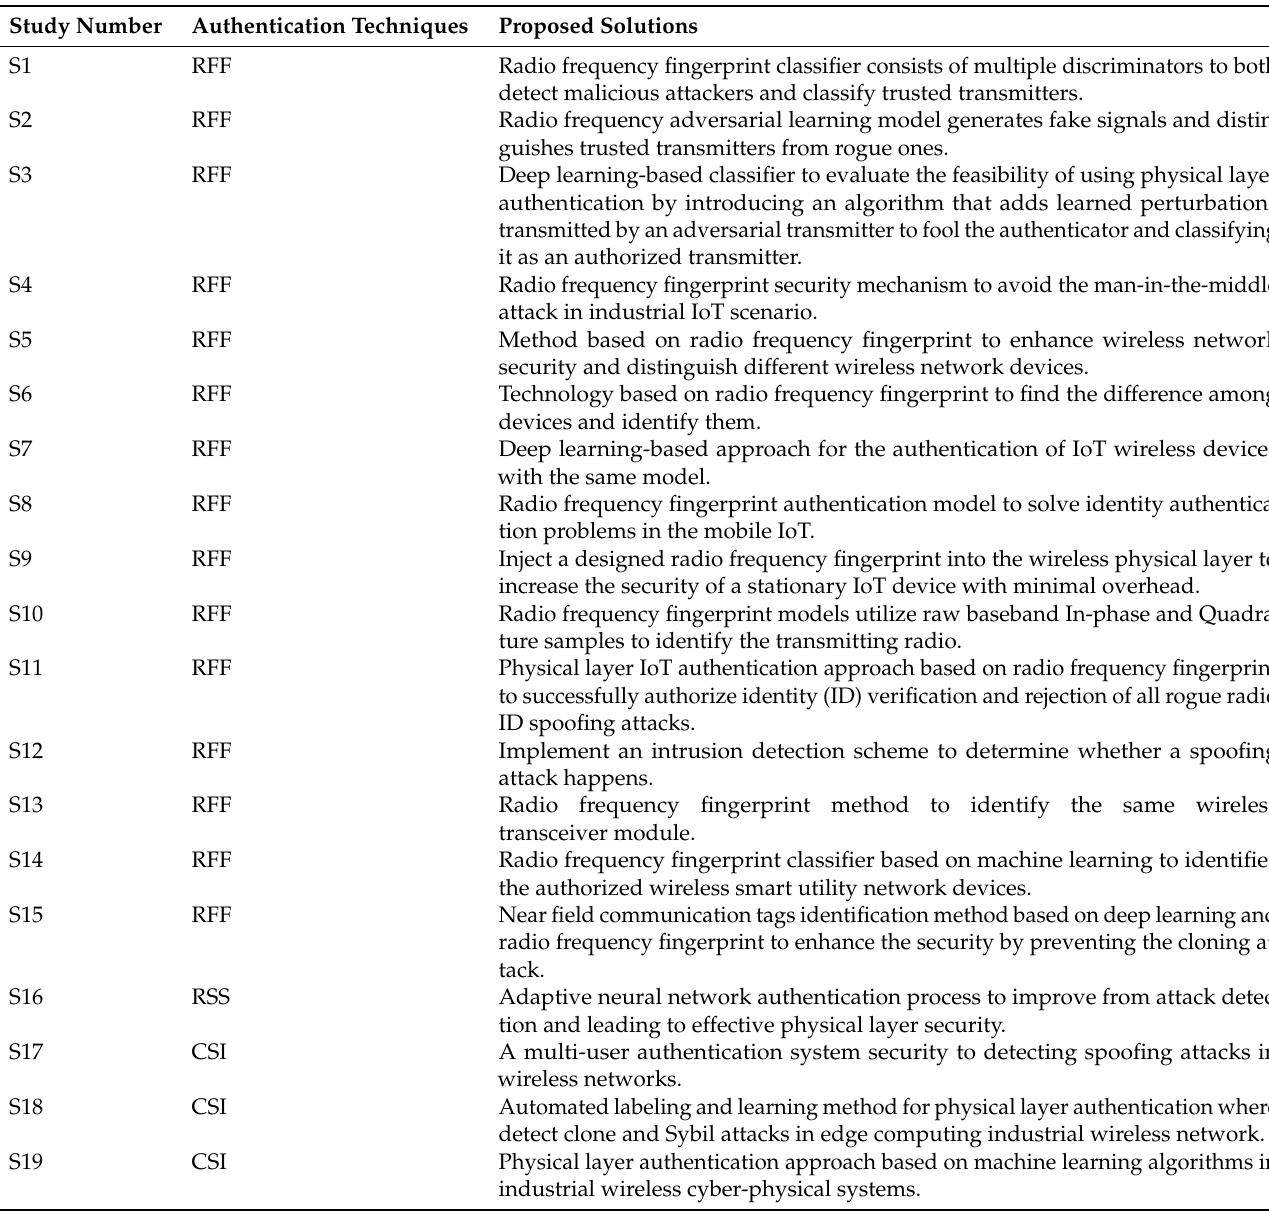
Table 7. Authentication techniques, proposed solution of existing studies on